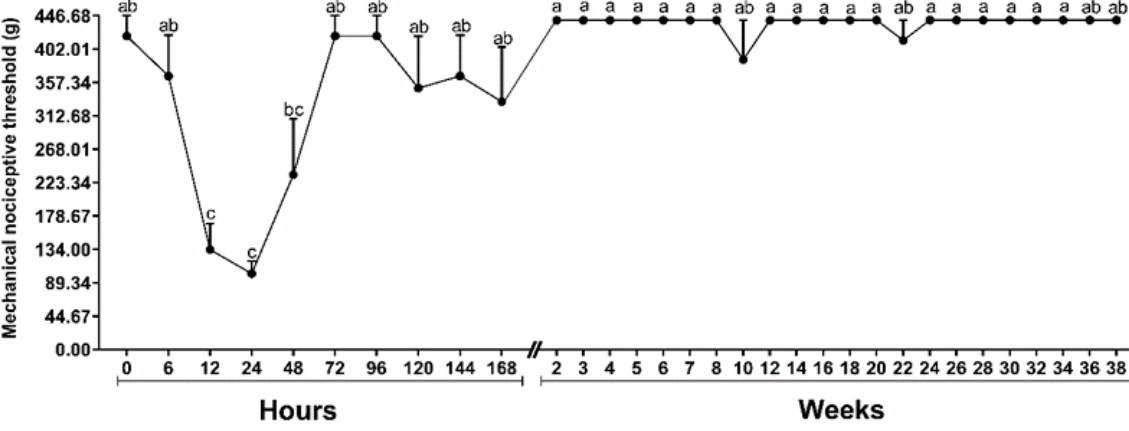
Figure 1. Graphic representation of the means ± standard error of the mechanical nociceptive threshold (MNT) of a horse submitted to the implantation of six polymers of poly(lactic acid) (PLA). Means followed by the same letter do not differ by the Tukey’s test ( p < 0.05) in each moment.